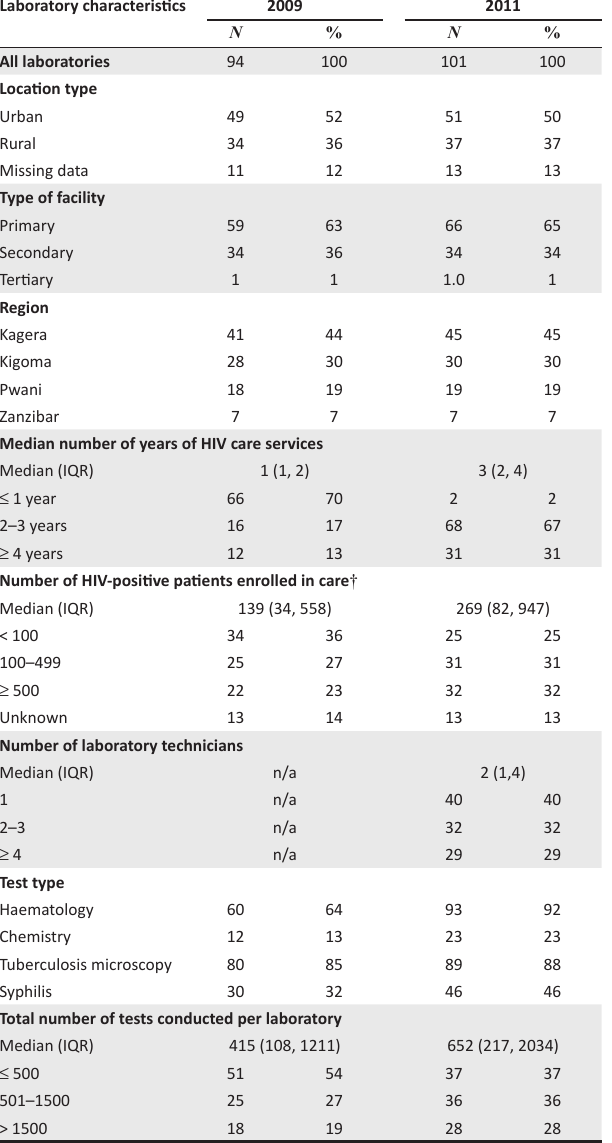
TABLE 1: Characteristics of PEPFAR-supported laboratories in Tanzania for which data were provided for 2009 and 2011. Laboratory